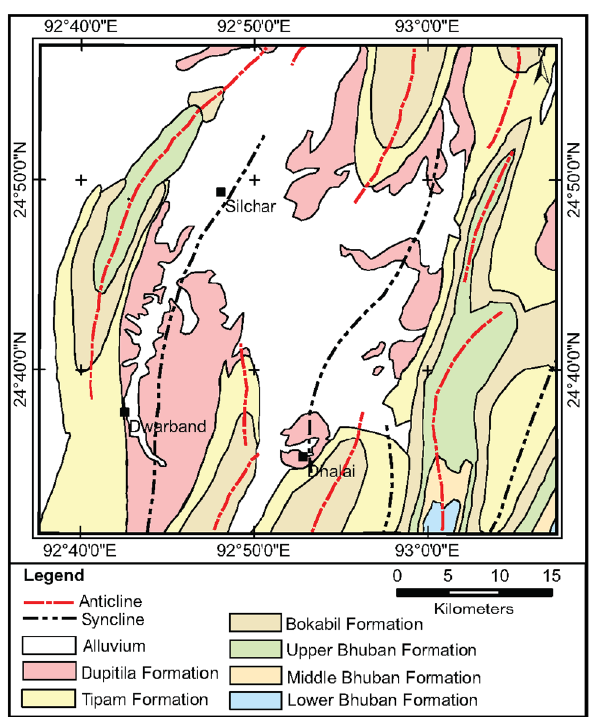
Fig. 2 Surface geological map of the study area (after Mazumder et al. 2016; Kamaraju 2010)